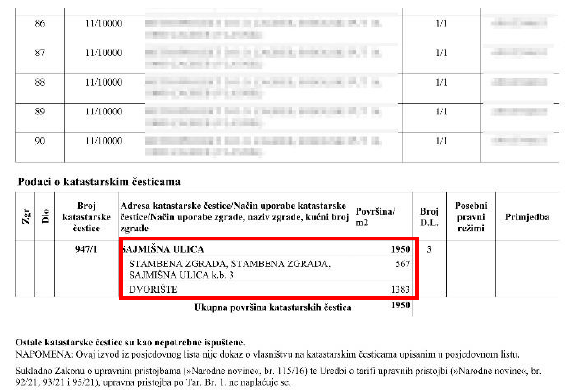
Figure 4. Excerpt from a Land